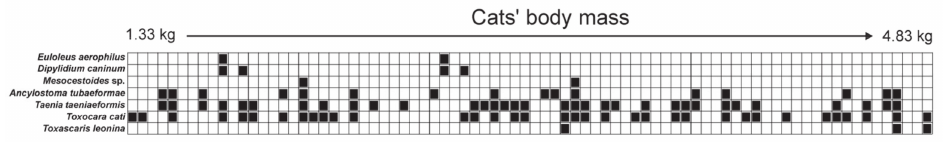
Figure 4. The seriation diagram using a constrained algorithm of parasites (presence / absence values) recorded in cats sorted according to their body